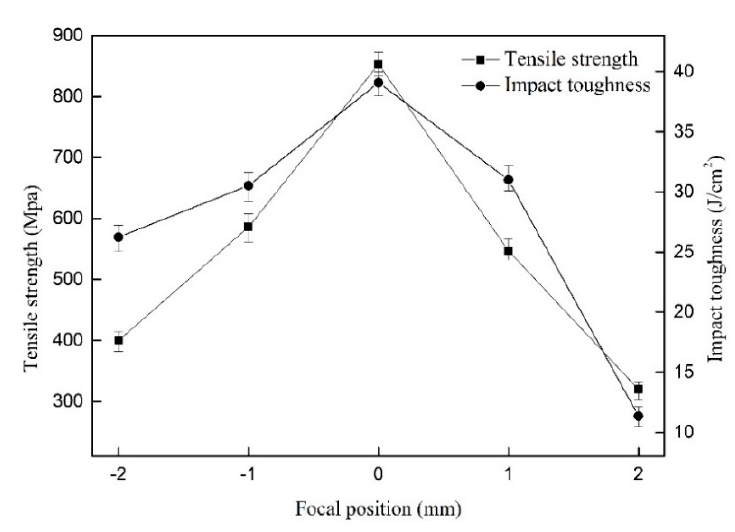
Figure 10. The influence of focal positions on tensile strength as well as impact toughness.